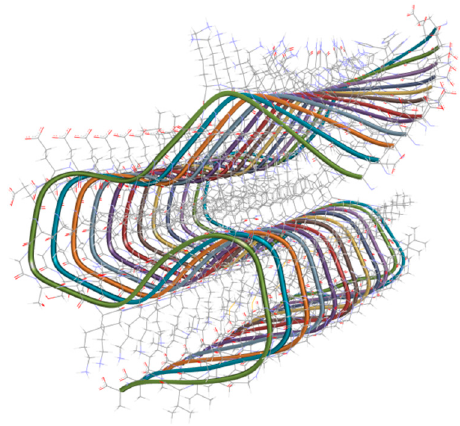
Figure 1. Three-dimensional ribbon structure of the 42-residue amyloid- β fibril (PDB code: 2MXU)